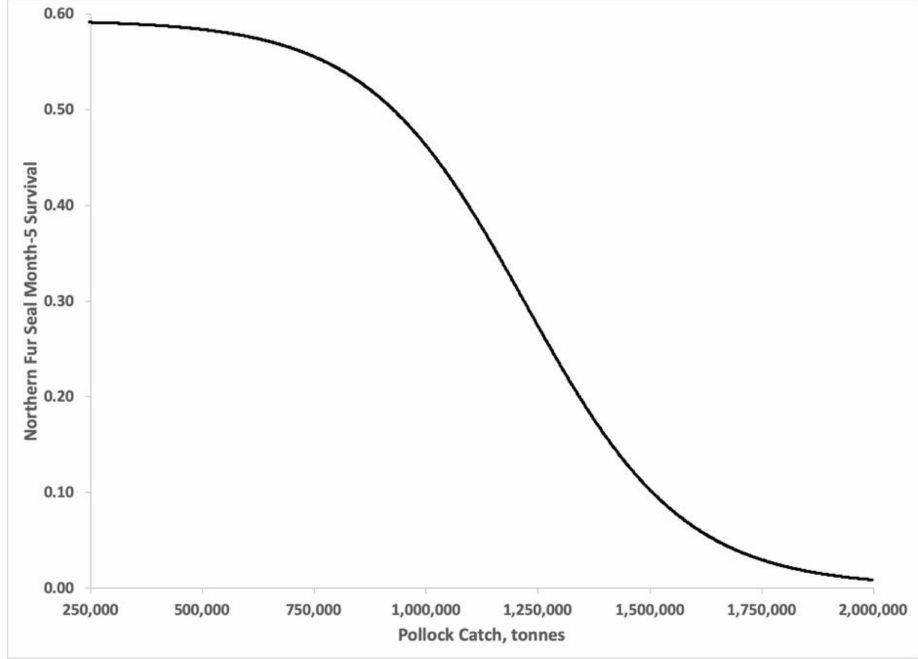
Figure 6. Logistic function modeling the relationship between pollock catch (t) within our Pribilof fur seal foraging area and month-5 survival of fur seal pups (Equation